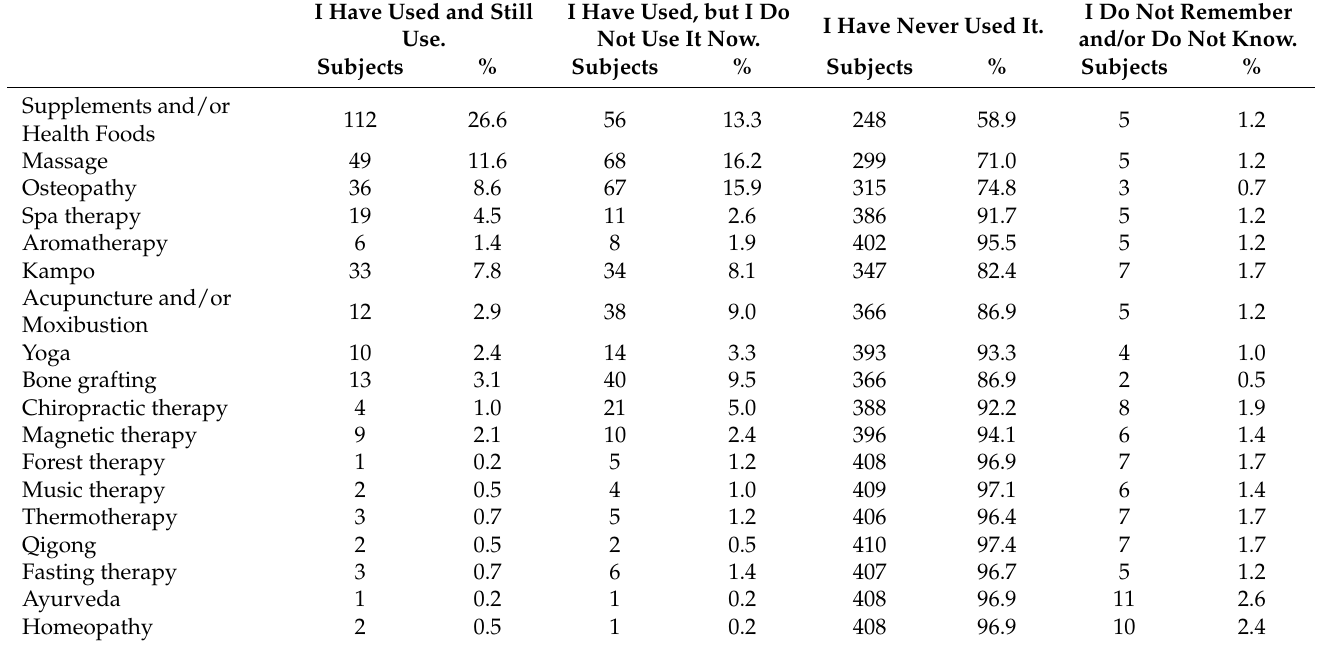
Table 2. Use of complementary and alternative medicine in patients with type 2 diabetes